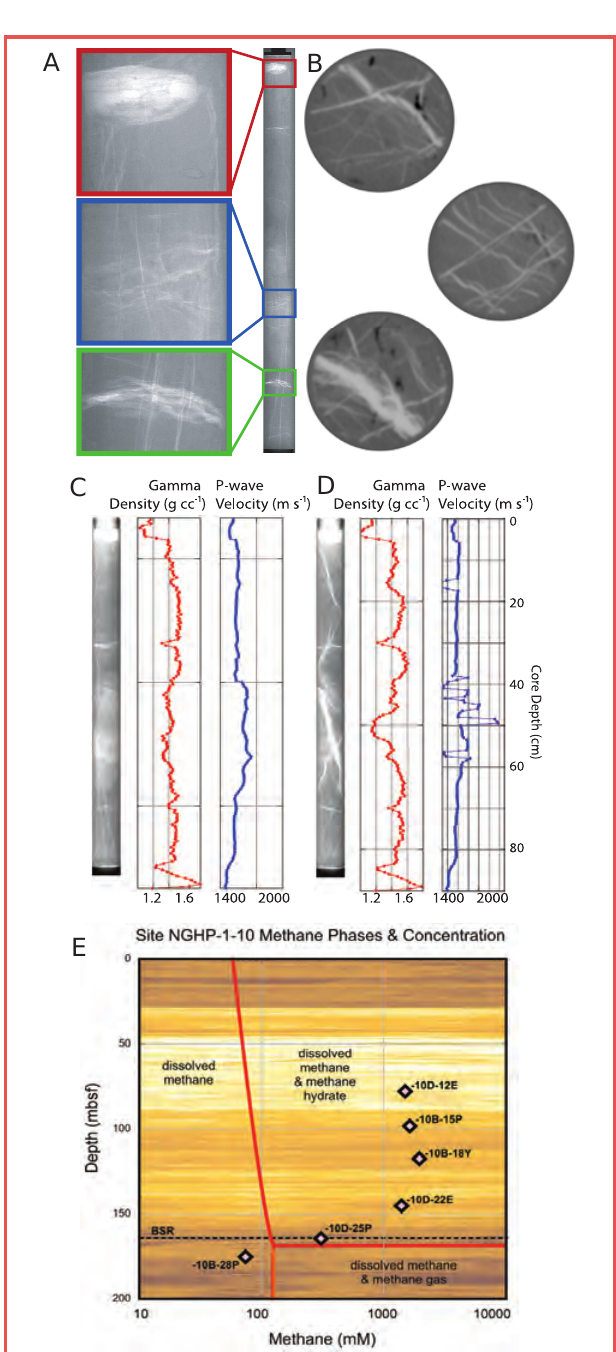
Figure 2. Data from a HYACINTH FPC core obtained on NGHP Exp. 1 using the PCATS and a medical CT scanner, and methane concentration data from the same site obtained from pressure cores. All data and images from Collett et al., 2008. In the X-ray images, denser features (carbonate nodules) are dark; less dense features (gas hydrate veins) are light. [A] X-ray image with enlargements showing different gas hydrate morphologies (nodules, lenses, veins) in fine-grained sediment. [B] Horizontal X-ray computed tomographic slices of the same pressure core showing the complexity of cross- cutting gas hydrate vein features present in this clay core. [C] and [D] Two sets of PCATS data (X-ray images, P-wave, and gamma density profiles) collected at right angles to each other on the same pressure core. [E] Logarithm of methane concentration vs. depth, plotted over phase boundaries for Structure I methane hydrate (calculated after Xu, 2002, 2004). Background image is resistivity-at-bit data (lighter=more resistive) collected in a nearby hole. Dashed line is extrapolated depth of seismic Bottom-Simulating Reflector (BSR) which agrees closely with the calculated thermodynamic Base of Gas Hydrate Stability (BGHS) as indicated by the solid horizontal line of the phase